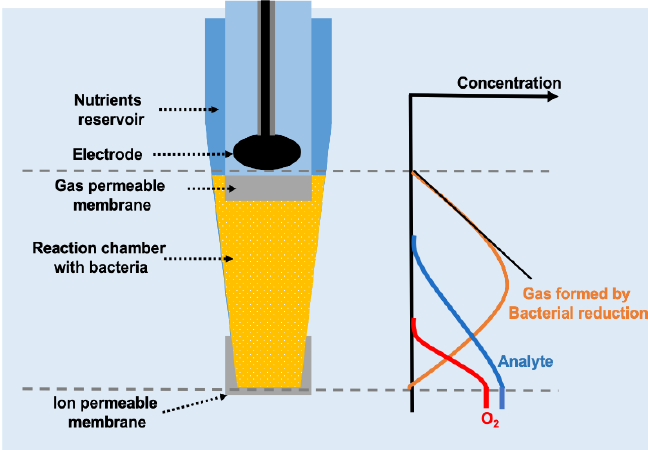
Figure 1. Schematic representation of biosensor based on bacteria respiring and thus reducing an electron acceptor such as NO 2 − to a gas (in this case N 2 O) that can be detected by an amperometric Clark-type gas sensor. Such sensors have been realized fore NO 2 − , NO x − (i.e., NO 3 − + NO 2 − ) and for SO 42 − that is reduced to H 2 S. (Original image from authors).